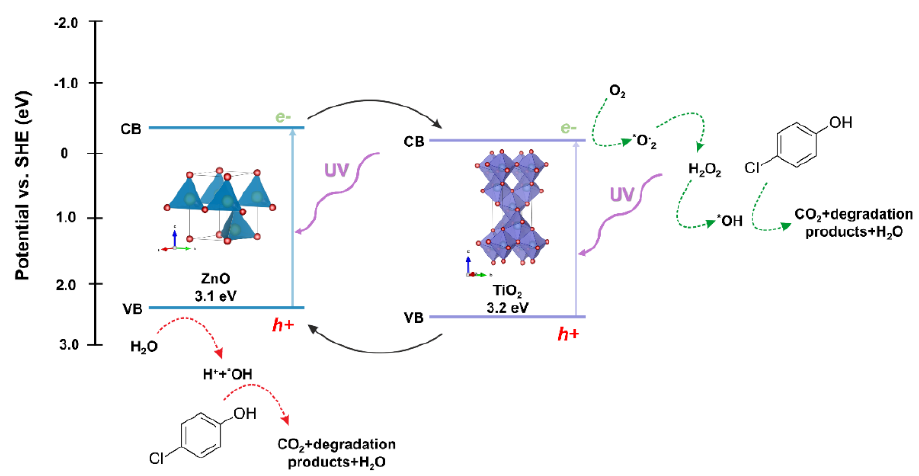
Figure 14. The proposed mechanism of photo-oxidation for 4-chlorophenol using TiO 2 -ZnO systems as photocatalysts.